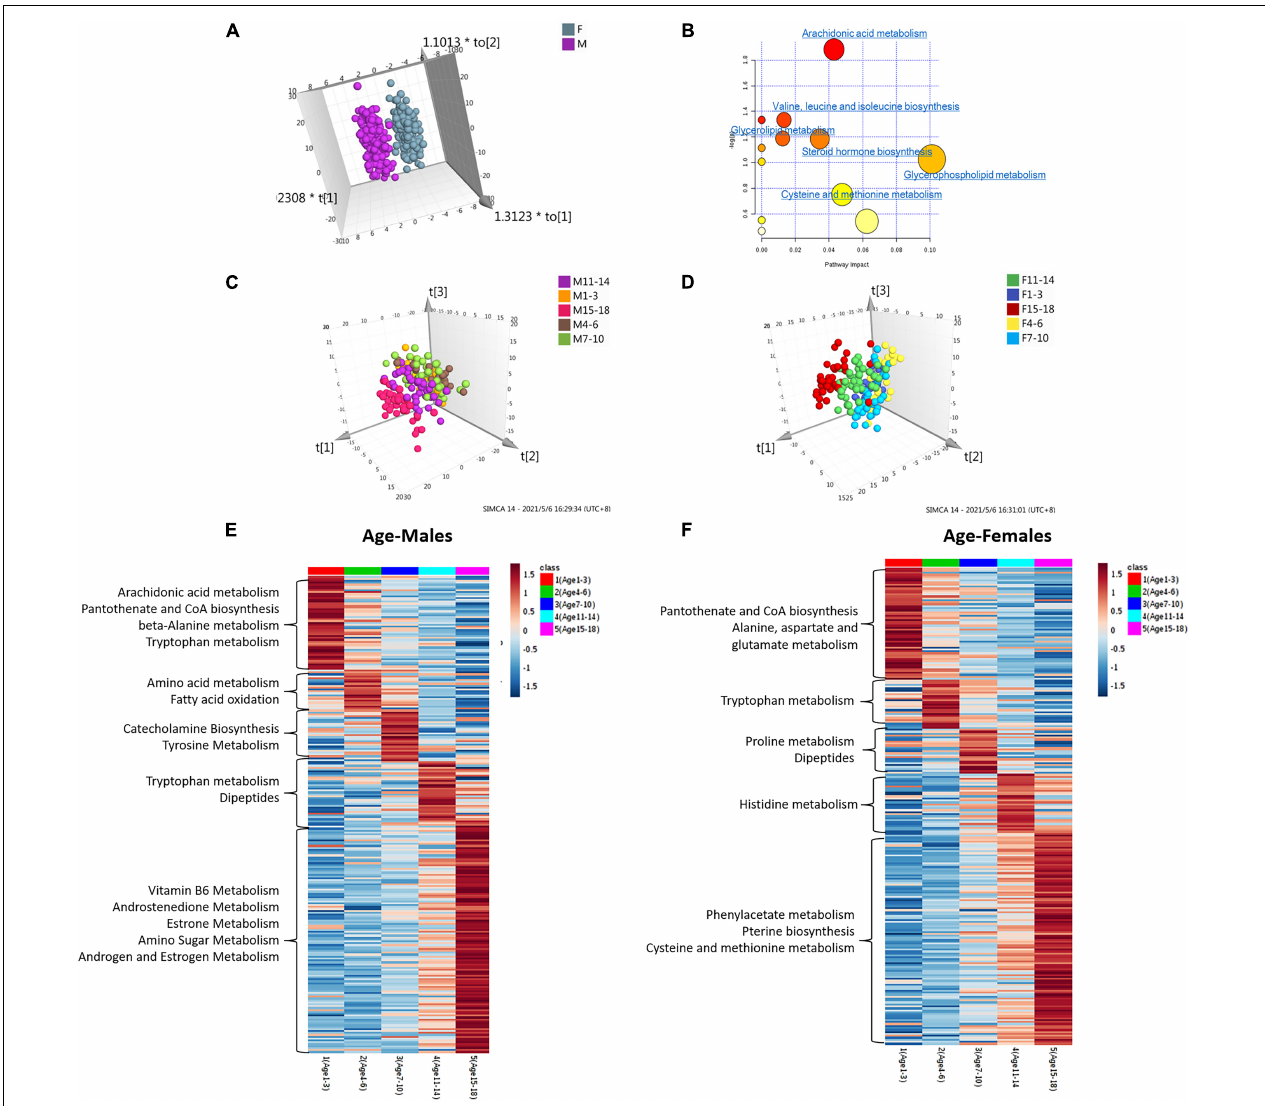
FIGURE 2 | Analysis of metabolome interindividual variations and related factors (gender and age). (A) The score plot of the OPLS-DA model between female and male children of all ages. (B) Pathway overrepresentation analysis of differential metabolites in the two sex groups. The analysis was carried out with the metabolites in changes ( P < 0.05). Pathway impact values were plotted against the X -axis, and P -values were plotted against the Y -axis. The node color is determined by its P -values, and the node size is proportional to the pathway impact values. (c,d) The score plot of the OPLS-DA model of male children (C) and female children (D) with different age stages. (E,F) Age-dependent metabolic pathways were enriched based on metabolites with the highest level in each age group. The KEGG database was the background pathway